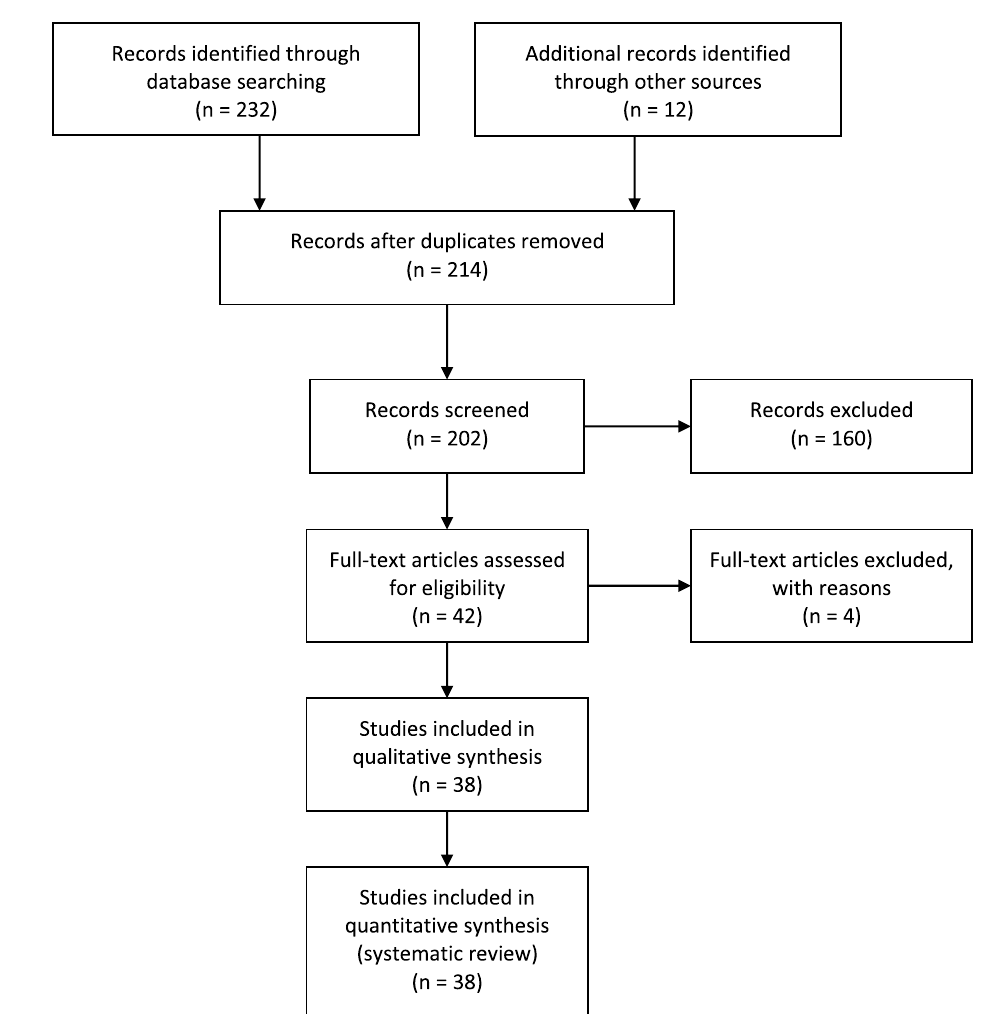
Fig. 1. PRISMA® fl ow diagram of the search processes and